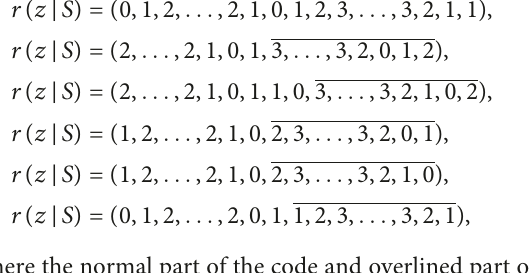
, for reference, see } F n n ) (cid:28) (